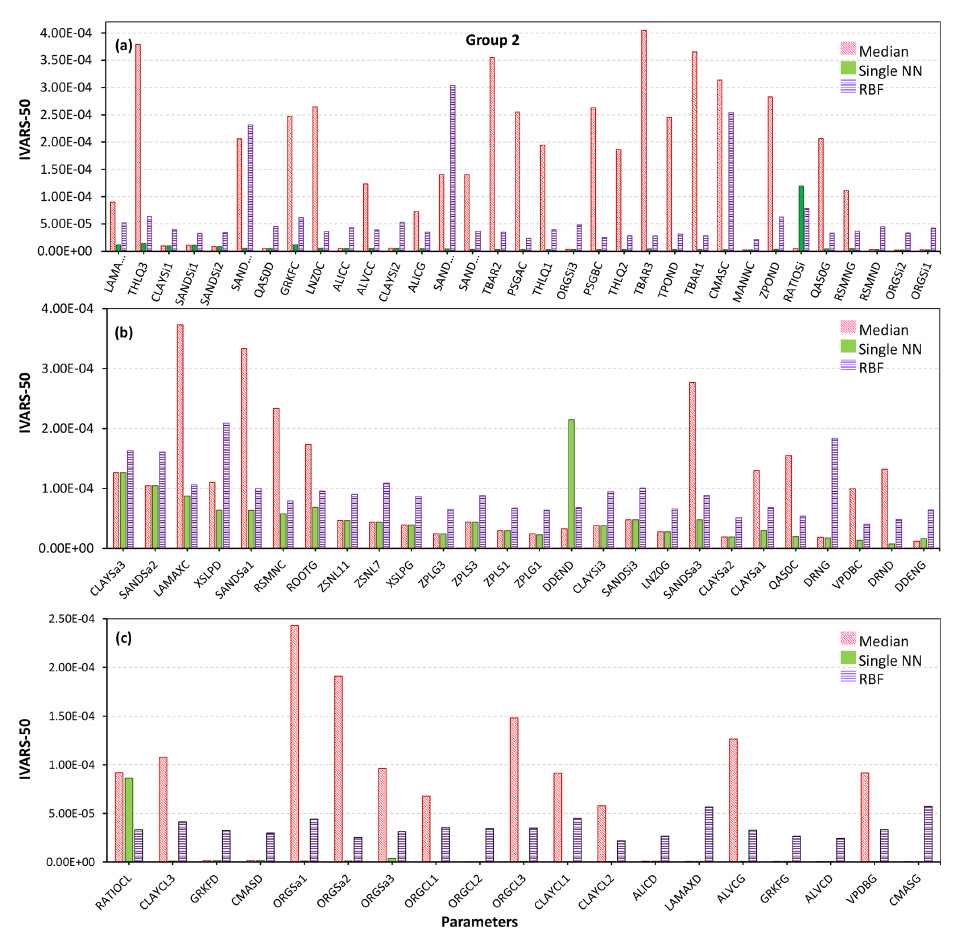
Figure 12. Sensitivity analysis results of the MESH model for moderately influential parameters using different crash-handling strategies. To better illustrate the results, the moderately influential parameters in Group 2 (see Fig. 10) are separately shown in panels (a) , (b) , and (c)